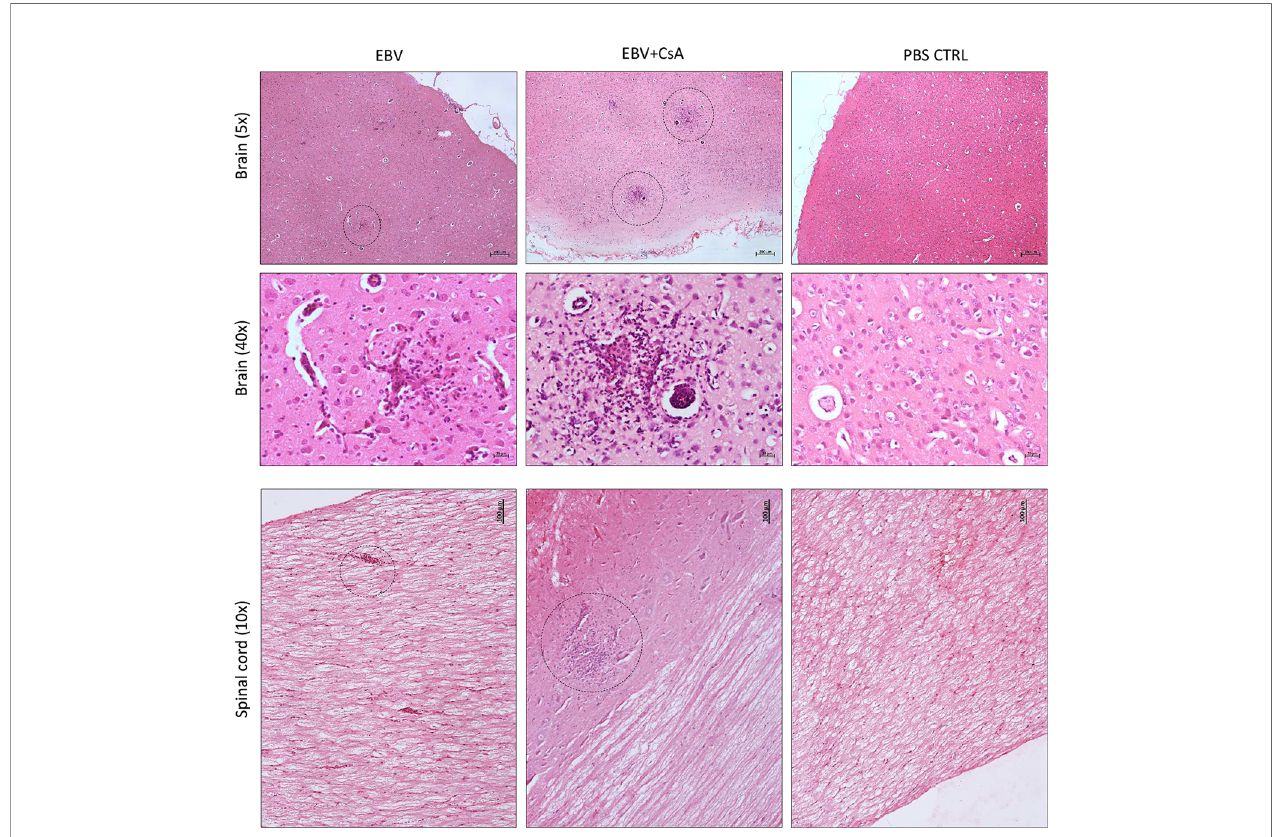
FIGURE 2 | Cell aggregation in the rabbit CNS. H&E staining of formalin- fi xed, paraf fi n-embedded sections of a brain and a spinal cord harvested from EBV, EBV +CsA and PBS control groups. Dotted circles point to well-demarcated cellular aggregates. 40×, 10× and 5× images show scale bar of 20 m m, 100 m m, and 200 m m,